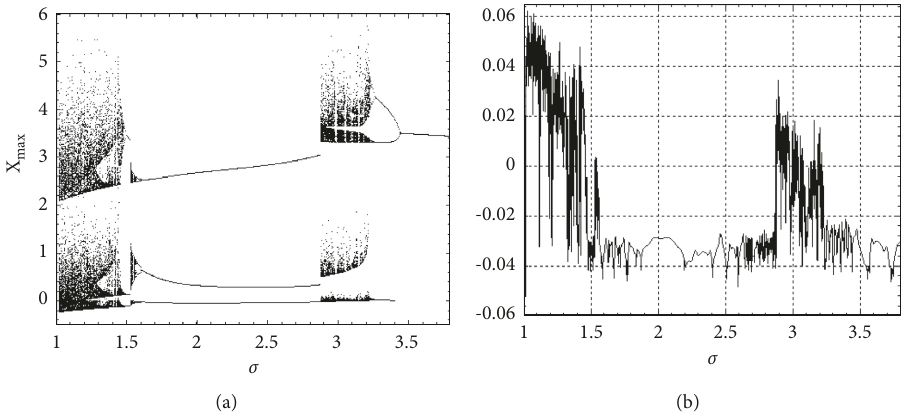
Figure 3: Bifurcation diagram and the corresponding maximum Lyapunov exponent L � L J � 5 × 10 − 6 kgm 2 , b � 2.3 ∗ 10 − 2 N/rad/s, and c � 30; σ (1 to 3.8); u � 0.009; β � 0.03; v � 0.005; T 3 � 0.01; the initial conditions are x � 0.01; y � 0.01; z � 20.